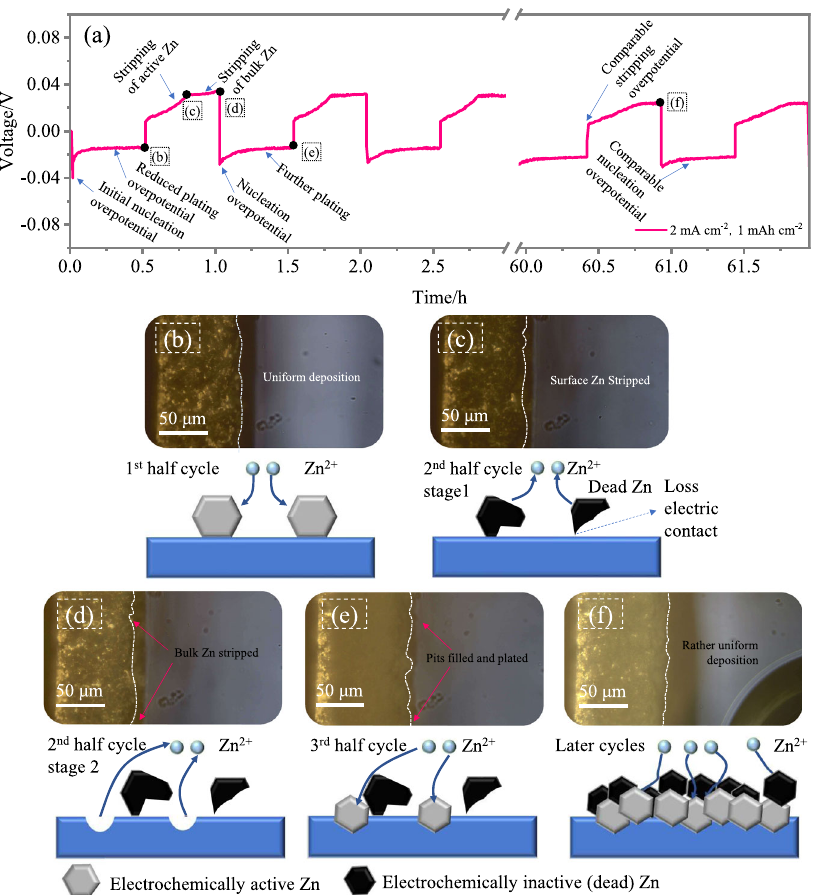
Fig. 3 Potential pro fi les and morphology evolution of the initially plated Zn metal electrodes. a Voltage evolution of P-Zn. b – f The optical micrographs and the corresponding schematic fi gures displaying the morphology of the positions marked in ( a